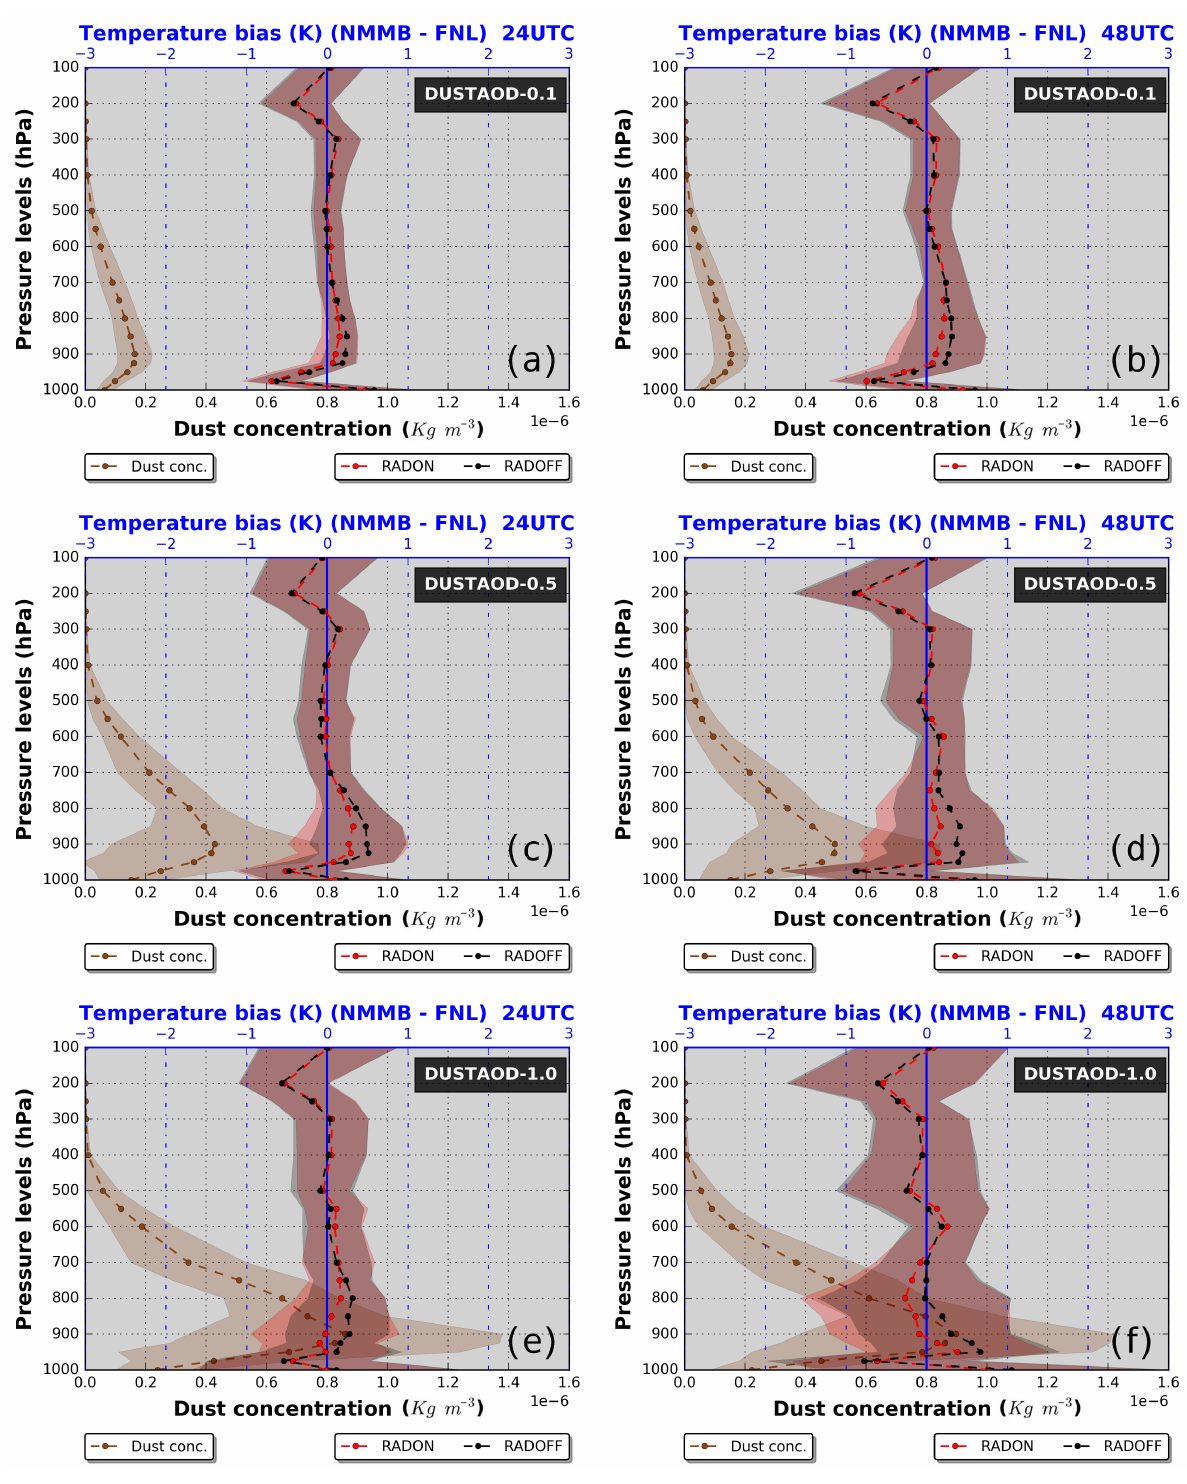
Figure 12. Vertical profiles of the regional temperature RADON-FNL (red curve) and RADOFF-FNL (black curve) biases calculated over grid points (1 ◦ × 1 ◦ spatial resolution) where the dust AOD at 550nm is higher than or equal to (a, b) 0.1, (c, d) 0.5 and (e, f) 1.0. In addition, the vertical profiles of the simulated dust concentration (in × 10 − 6 kgm − 3 ) are provided (brown curve). Each profile corresponds to the mean value calculated from the 20 desert dust outbreaks which are considered while the shaded areas correspond to the associated standard deviations. The obtained results are valid (a, c, e) 24 and (c, d, f) 48h after the initialization of the forecast